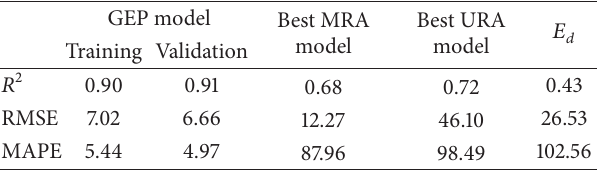
Table 6: Statistical parameters for predicting 𝐸 𝑠